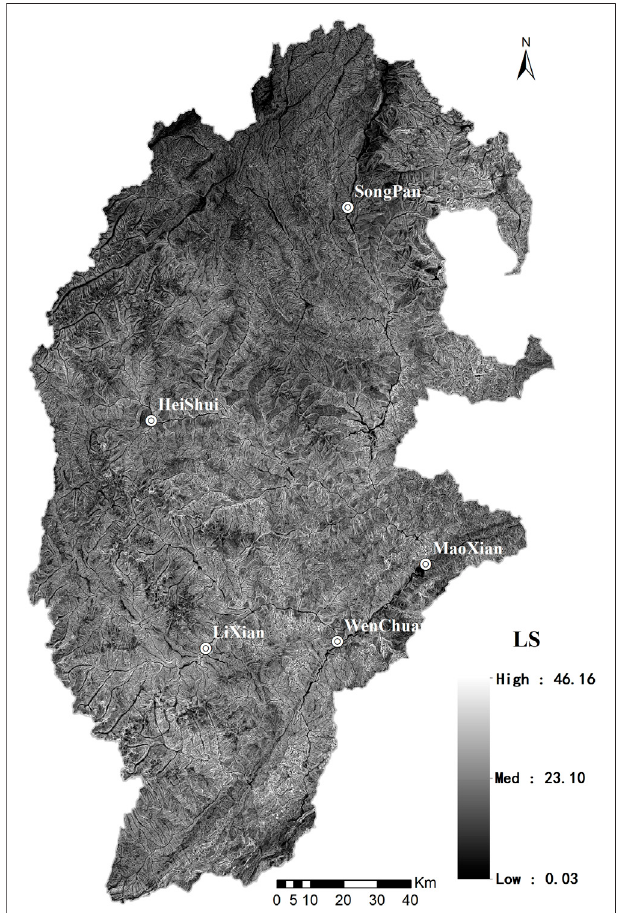
FIGURE 5 | LS of the upper reaches of Minjiang